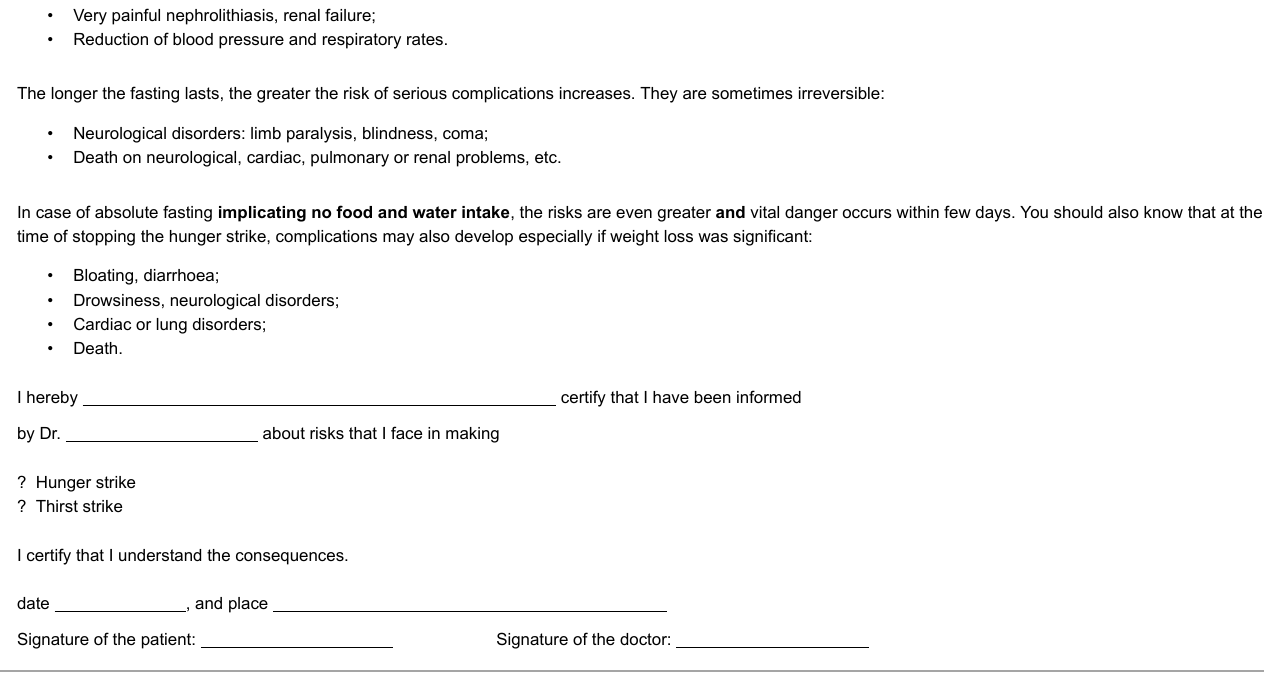
medical record by two different people